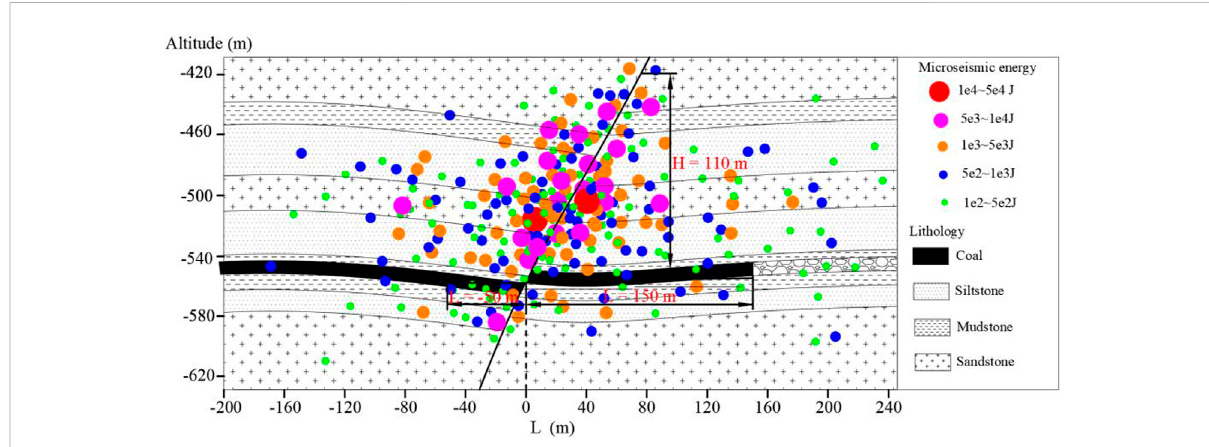
FIGURE 2 Distribution of microseismic events when mining the panel through the fault.